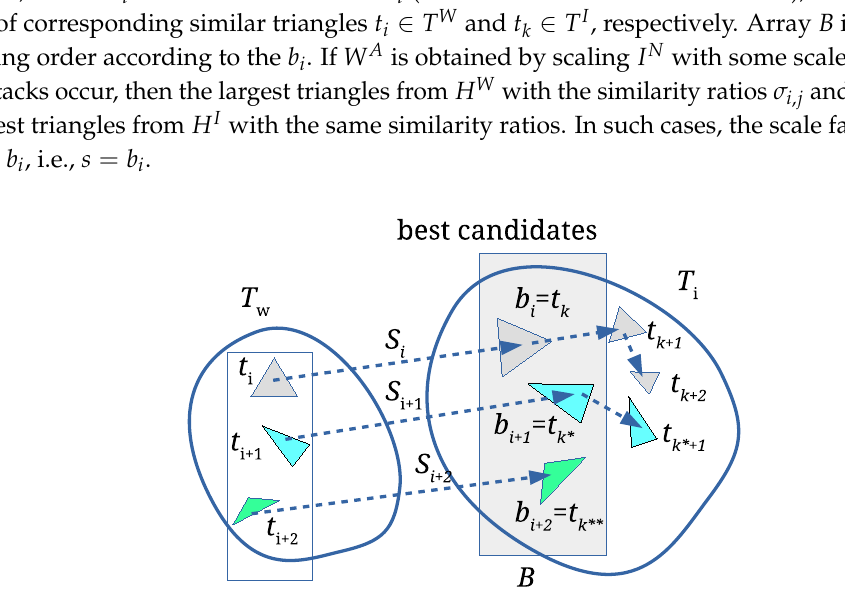
Figure 3. Array of scaling factors S i binds the best candidates ( b i , b i + 1 , and b i + 2 ) for scale